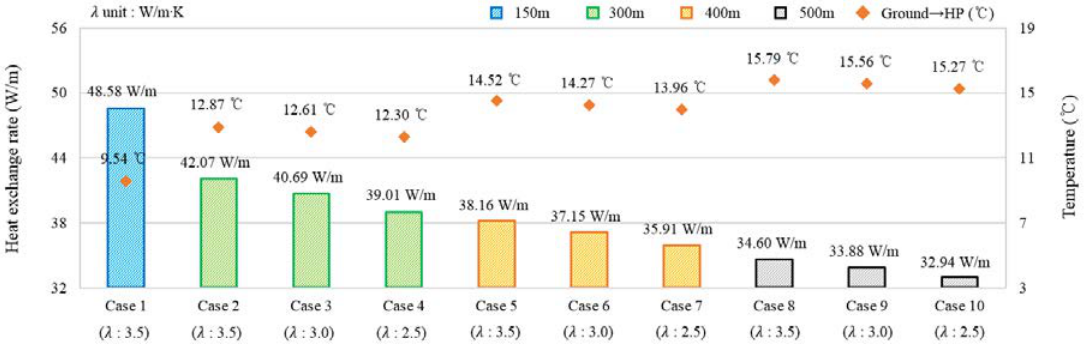
Figure 7. EWT and HER according to the thermal conductivity and the length of the GHX.